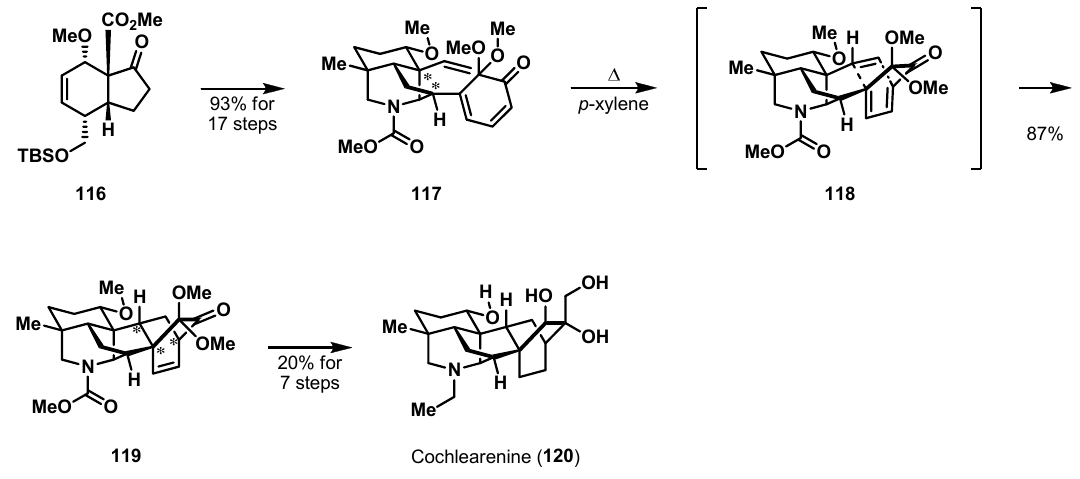
Scheme 18. Total synthesis of cochlearenine ( 120